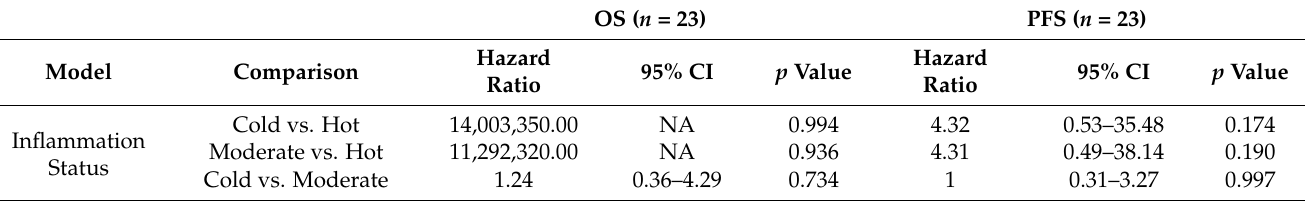
Table 3. OS and PFS in IMD-treated patients.